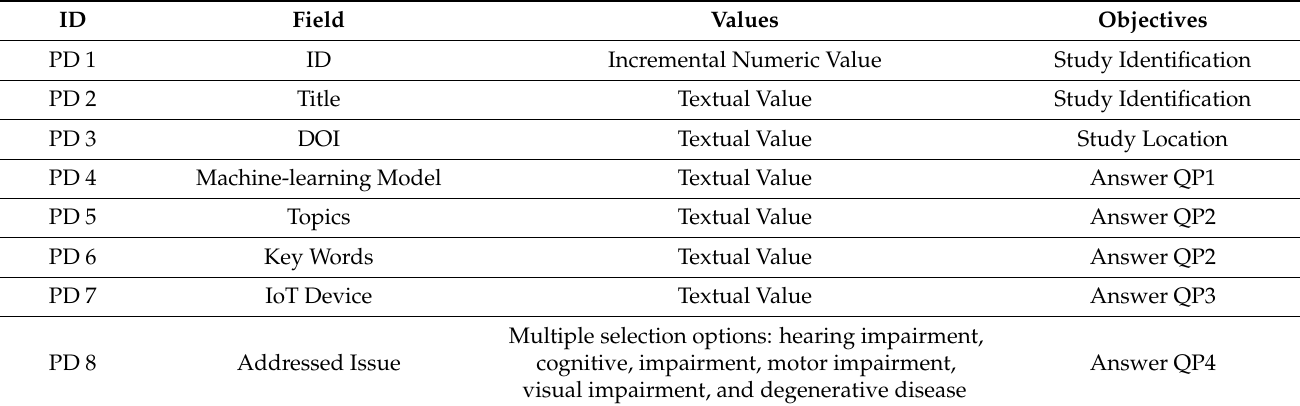
Table 8. Data extraction